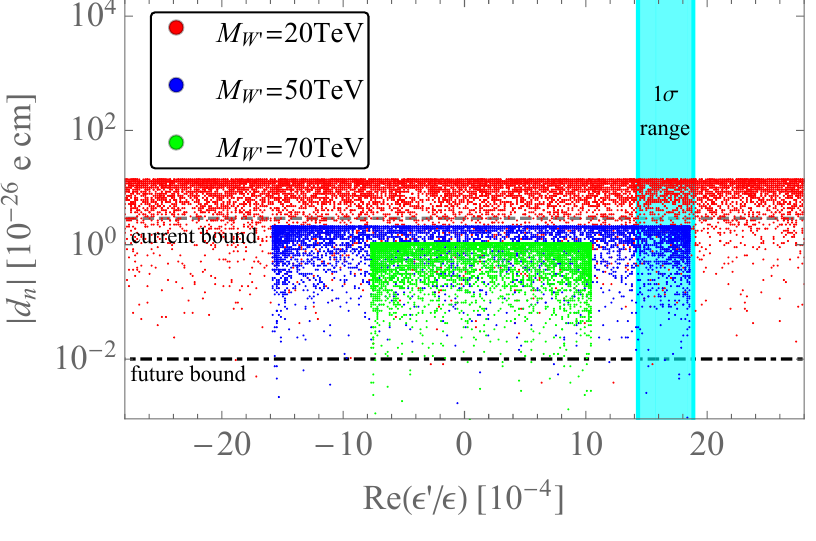
Figure 6 . The same (cid:12)gure as (cid:12)gure 5 with Peccei-Quinn mechanism.